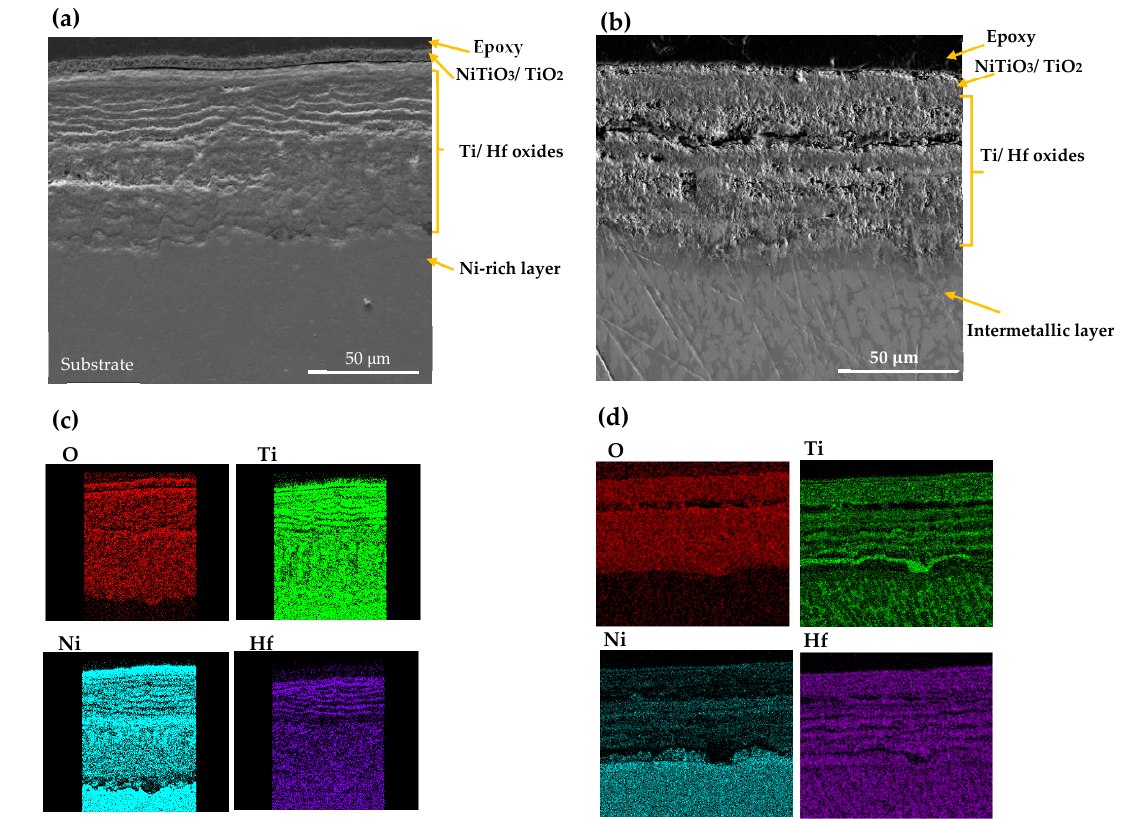
Figure 7. SEM image and X-ray mapping of the cross section of oxidation scale. ( a , c ) AM NiTiHf at 800 °C; ( b , d ) AM NiTiHf at 900 °C.